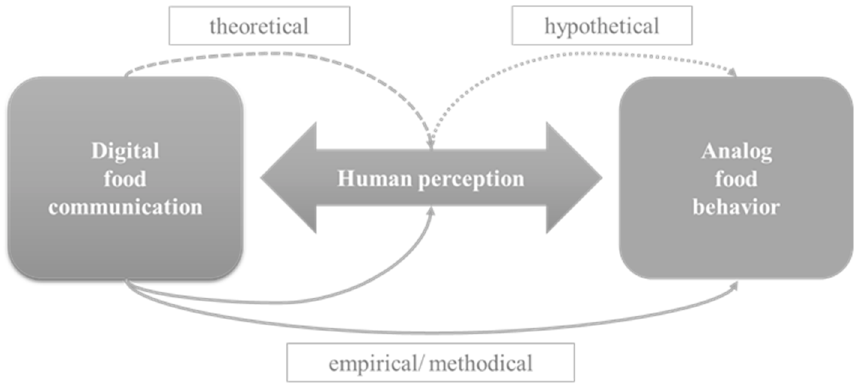
Figure 5. Analytical model of approved linkages of digital food communication, human perception, and analog food behavior.